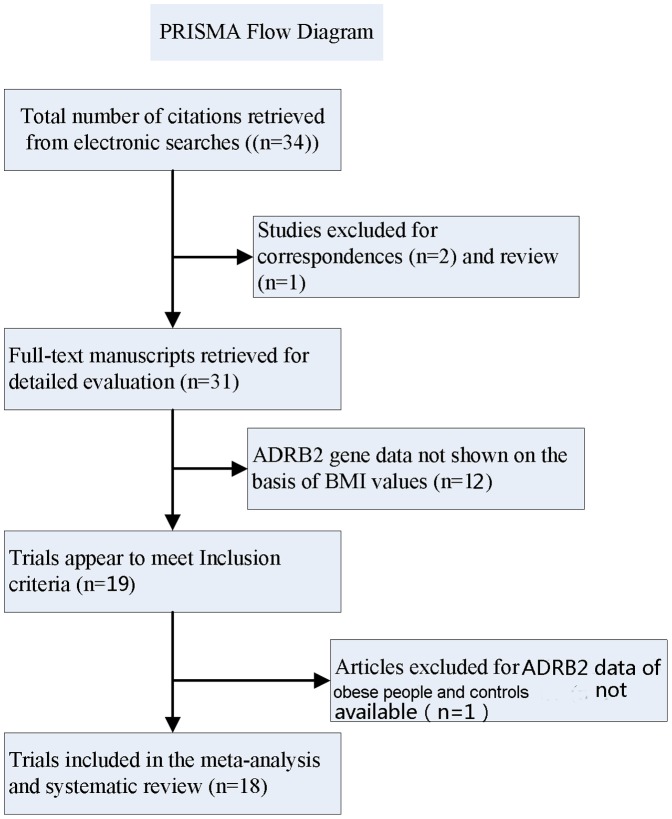
Flow diagram of articles selection process for ADRB2 gene polymorphism and obesity risk.